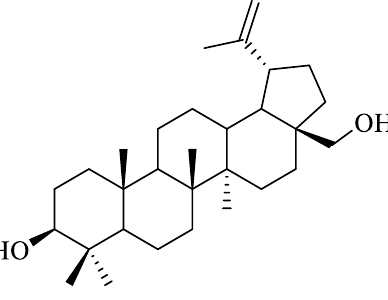
Figure 1. Structure of betulin (BE, 1 ).